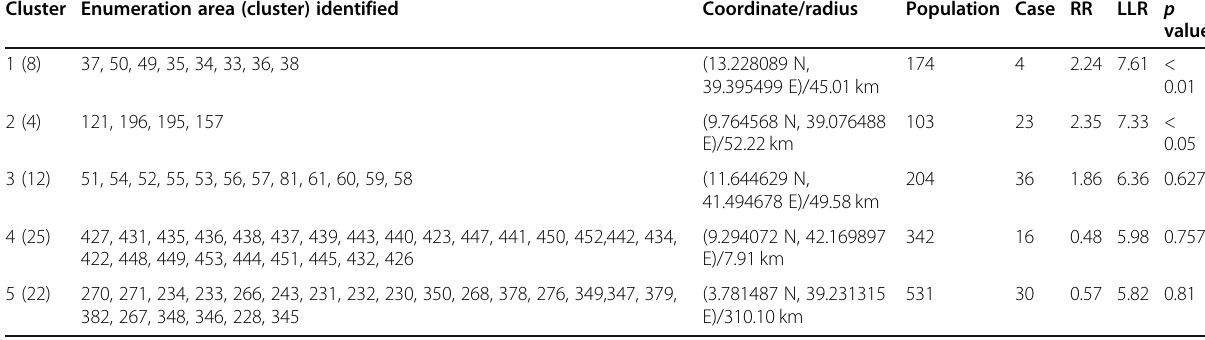
Table 2 Spatial scan statistical analysis of hotspot areas of infant mortality in Ethiopia, 2000 Cluster Enumeration area (cluster) identified Coordinate/radius Population Case RR LLR p